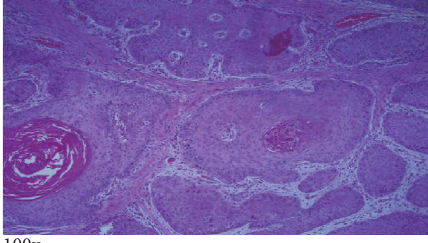
Figure 9: Right shoulder invasive cutaneous SCC measuring 7.8 cm, excised a few years ago, showing “nests” of deep dermal and subcutaneous invasion [2].